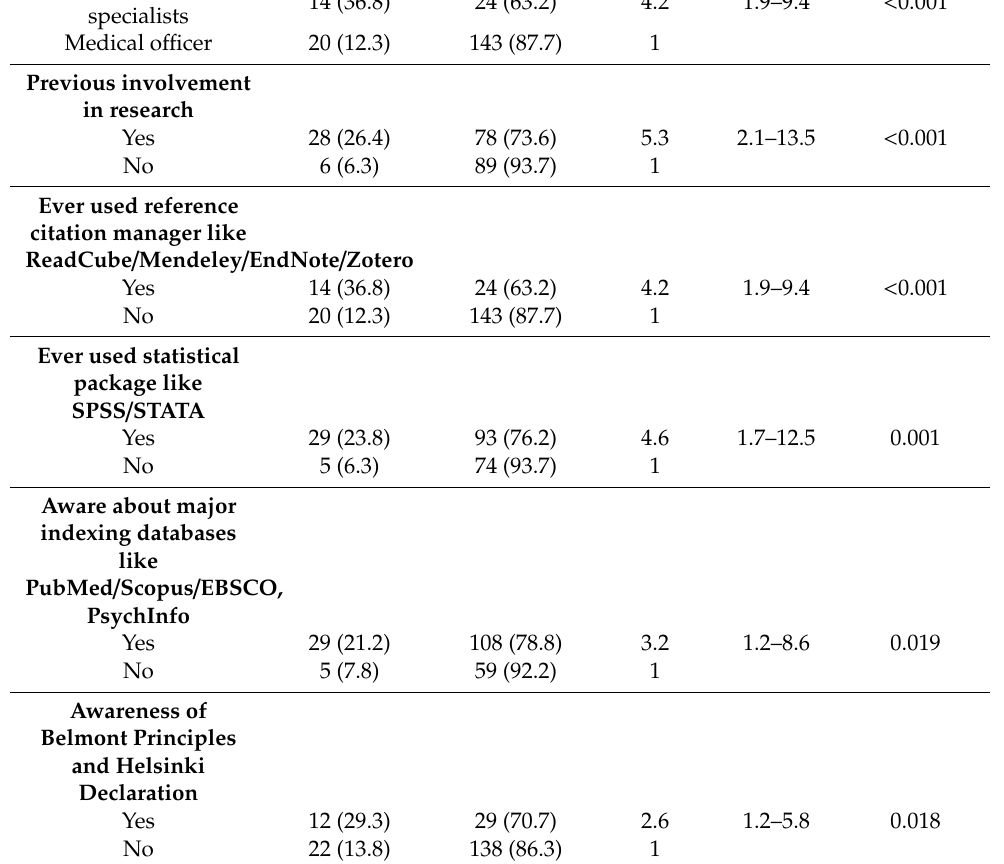
Table 5 exhibits the associations between journal selection attributes and publication output among clinicians. The odds of having published a scientific paper was higher among clinicians who emphasized greater importance on peer reviewed (OR = 2.5, 95% CI 1.1–5.5, p = 0.015); open